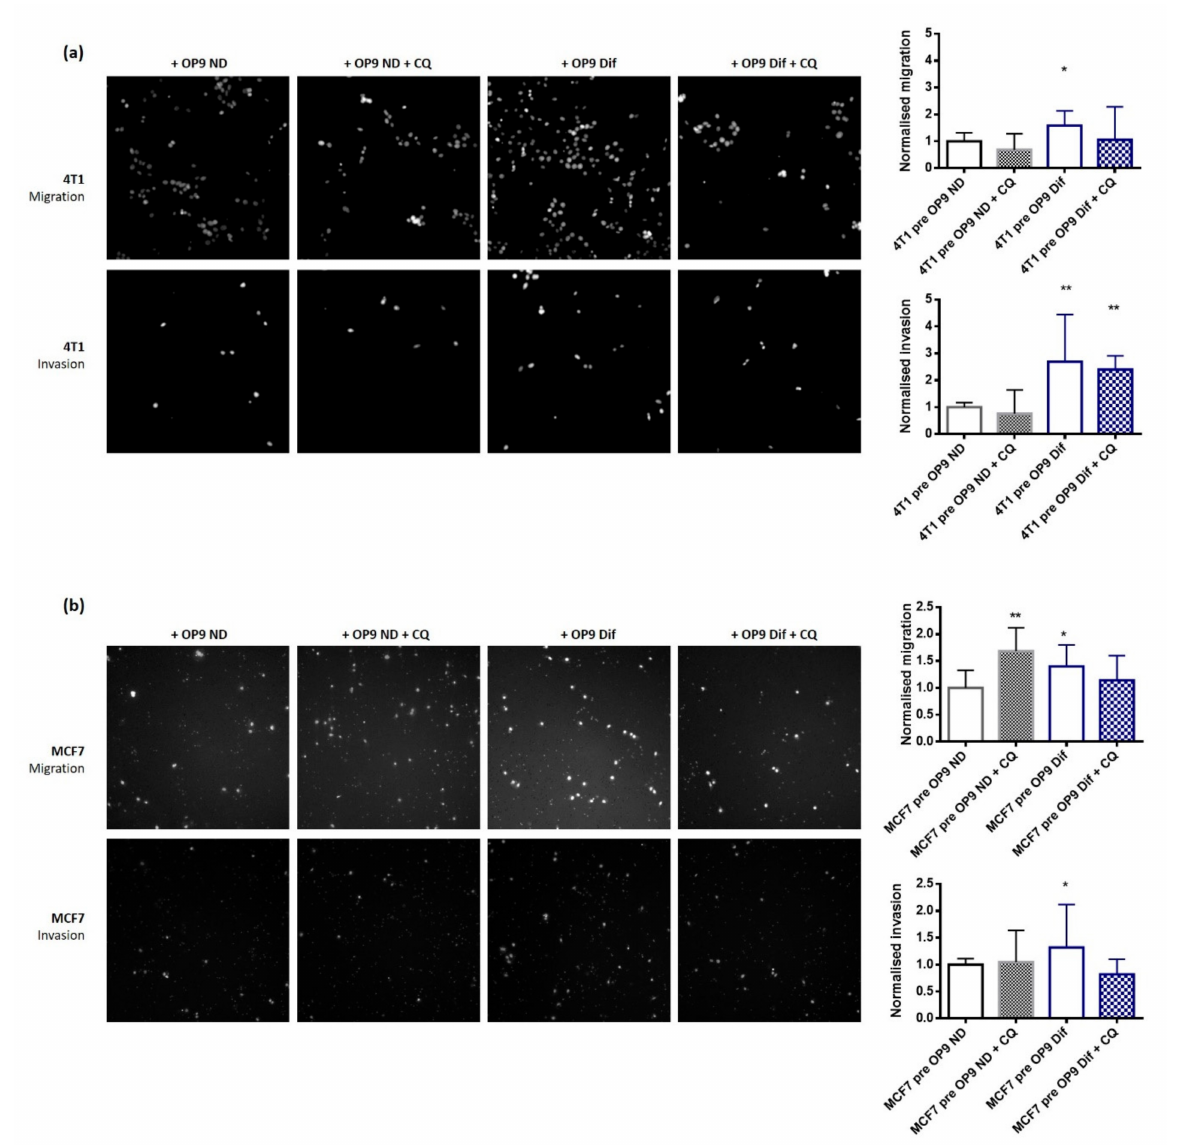
Figure 7. Activation of autophagy by adipocytes promotes cancer cell migration. ( a , b ) 4T1 ( a ) and MCF7 ( b ) cells were co-cultured with OP9 ND and OP9 Dif for 48 h and then subjected to cell migration and invasion assays with and without chloroquine (CQ) 20 µ M for 24 h (Median ± interquartile range, Wilcoxon Signed Rank Test * p < 0.05 and ** p < 0.01, n =